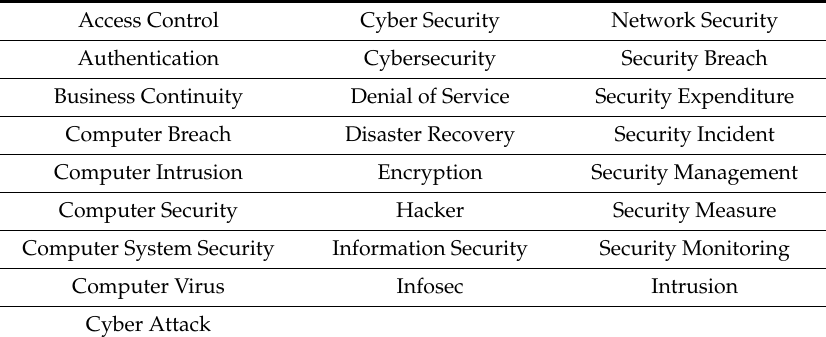
Table 2. The keywords used in Gordon et al.